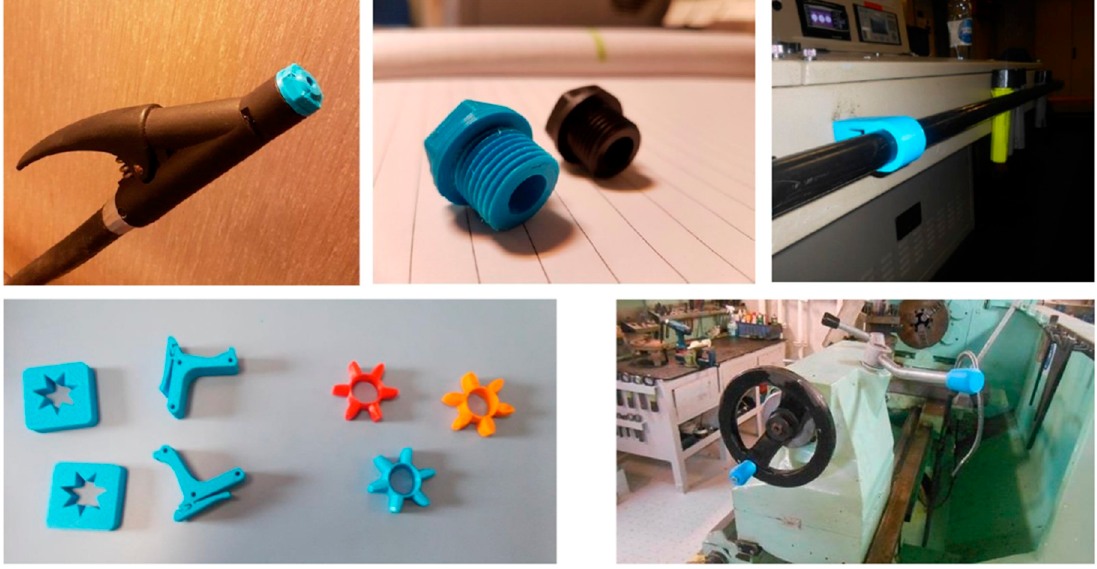
Figure 11. Components made by onboard 3D printing [36].